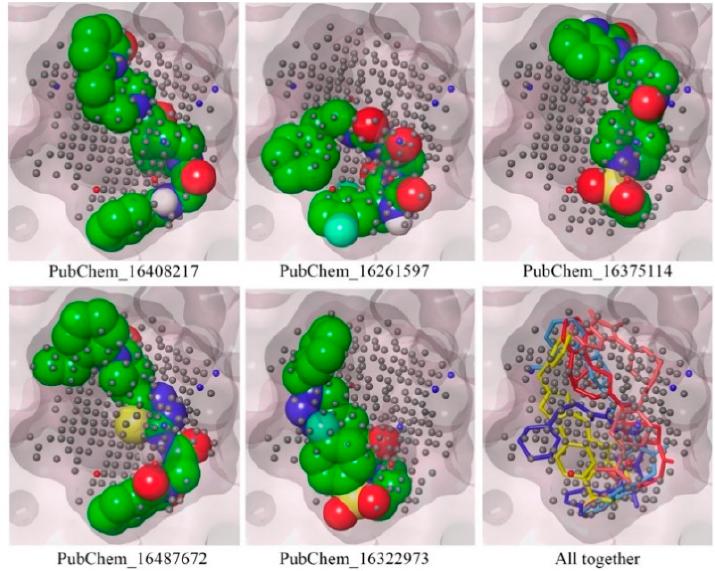
Figure 8. Mapping of final proposed CYP3A5 molecules on the NIB model.